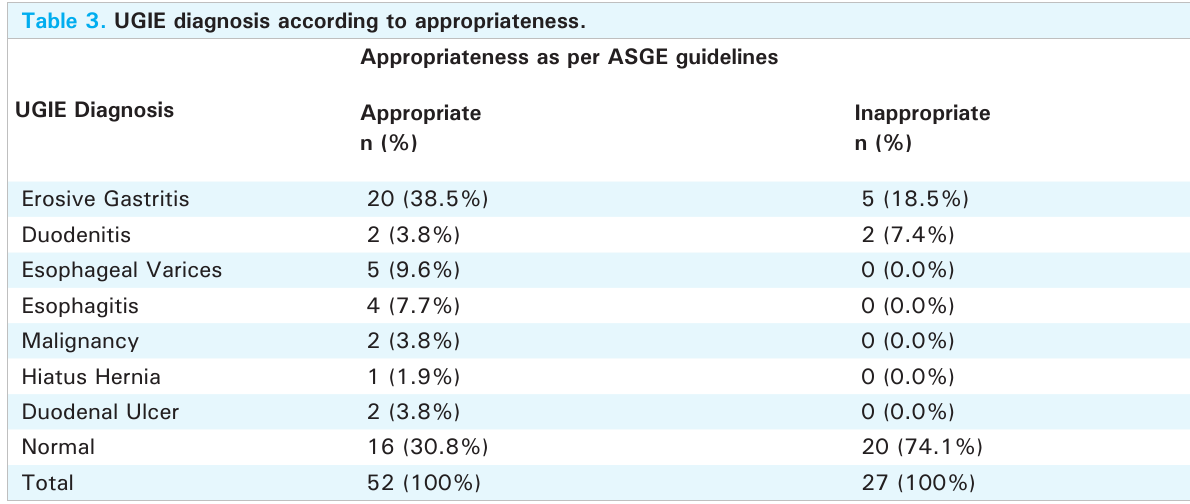
Table 3. UGIE diagnosis according to appropriateness.